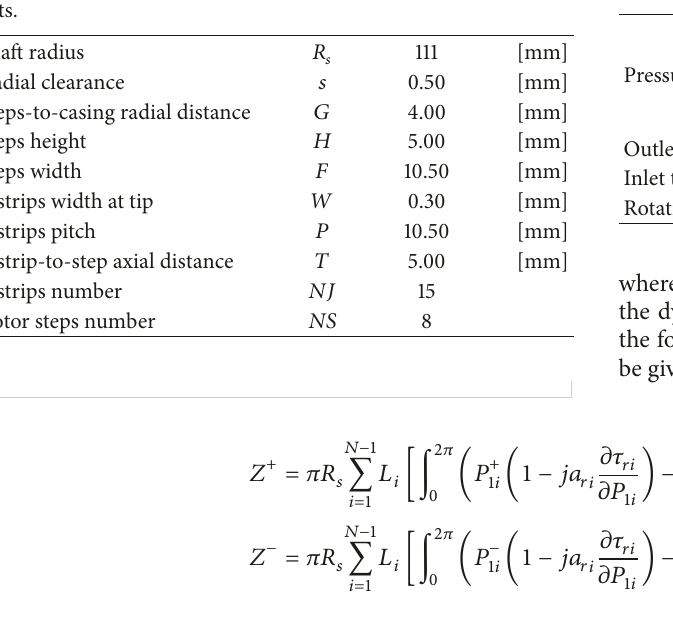
Table 6: Operating conditions of the experimental